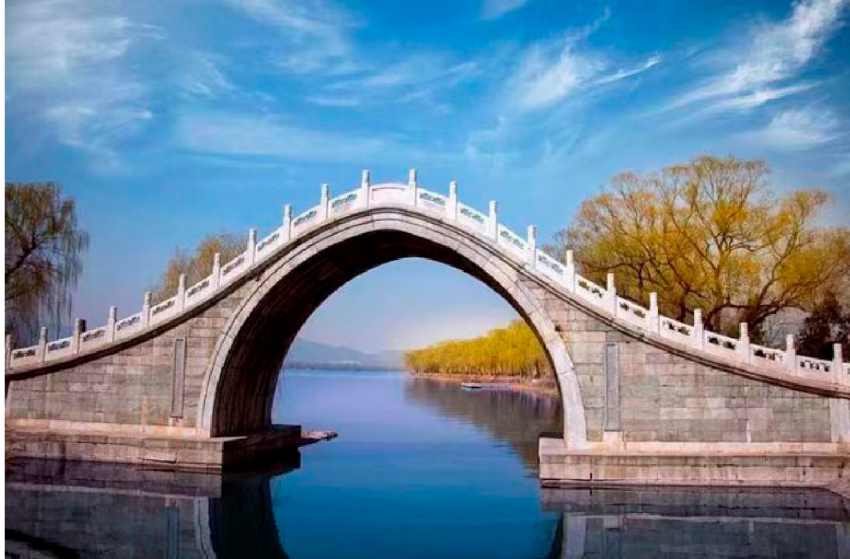
Figure 11. Original drawing of the bridge.